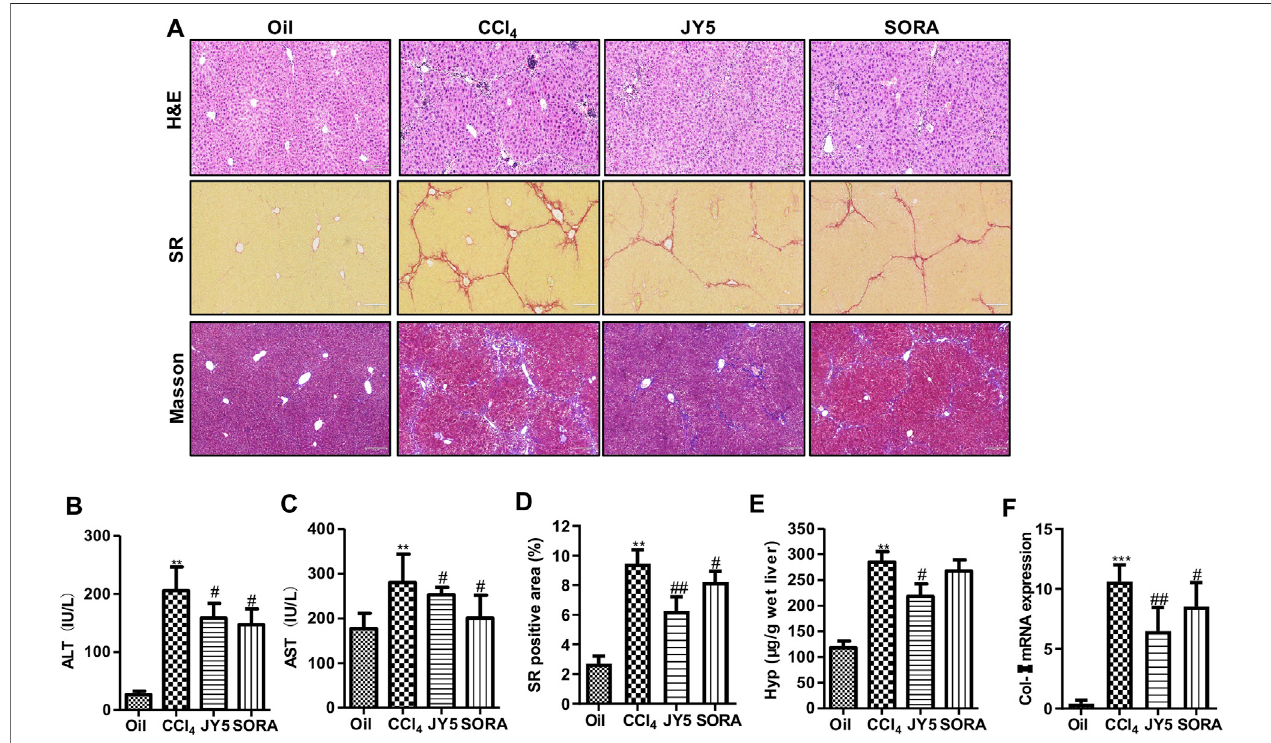
FIGURE 3 | JY5 significantly alleviates hepatic in fl ammatory injury and collagen deposition in CCl 4 -induced mouse liver fi brosis. (A) H&E staining (100 × ), SR staining (100 × ) and Masson staining (100 × ) in liver tissue. Serum levels of ALT (B) and AST (C) were measured in each group. (D) Semi-quantitative analysis of collagen disposition (%) in SR-stained liver sections. (E) Hyp content in wet liver tissue was detected by alkaline hydrolysis. (F) The mRNA expression of Col-I in mice liver tissue was analyzed by qPCR. ** p < 0.01, *** p < 0.001 vs the control group, # p < 0.05, ## p < 0.01 vs the CCl 4 group. Oil: control